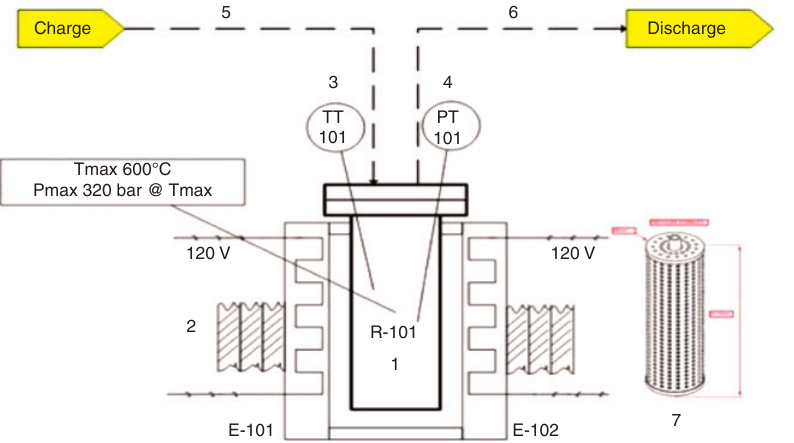
Figure 1: Experimental apparatus: 1, reactor; 2, heater; 3, temperature sensor; 4, pressure gauge; 5, feedstock; 6, product; 7, catalyst